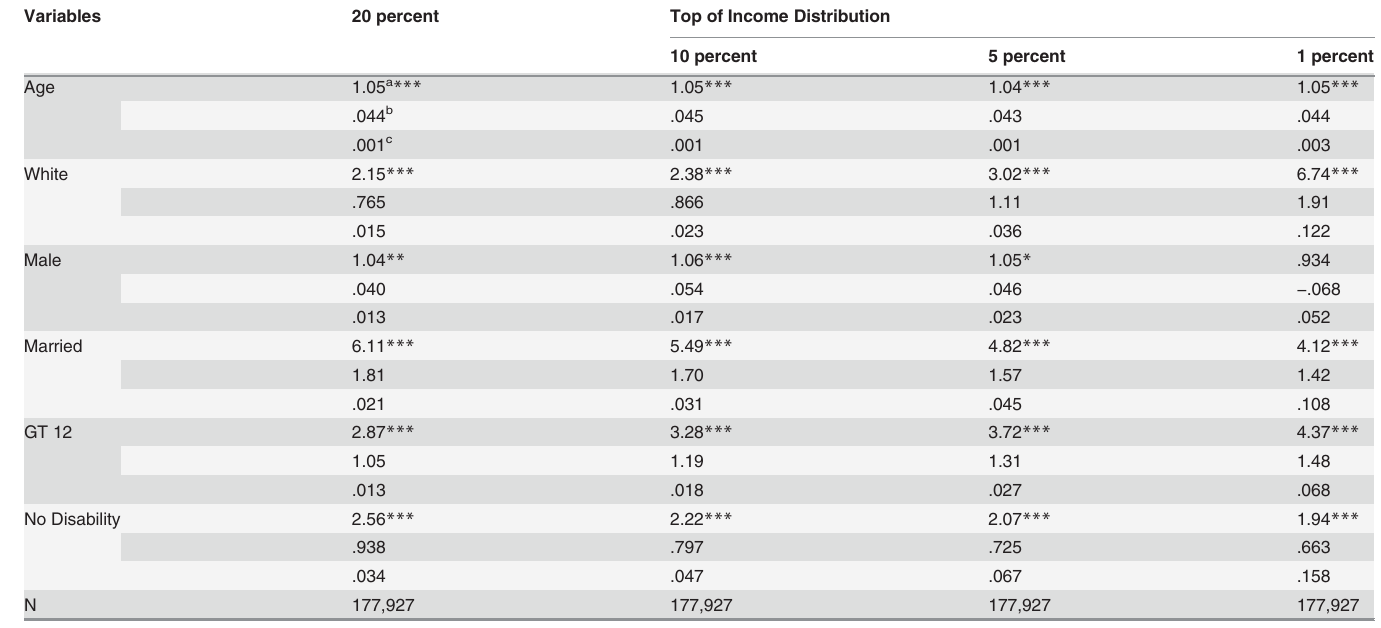
Table 4. Logistic Regression Model Odds Ratios, Coef fi cients, and Standard Errors Predicting the Occurrence of Various Levels of Af fl uence Between the Ages of 25 and